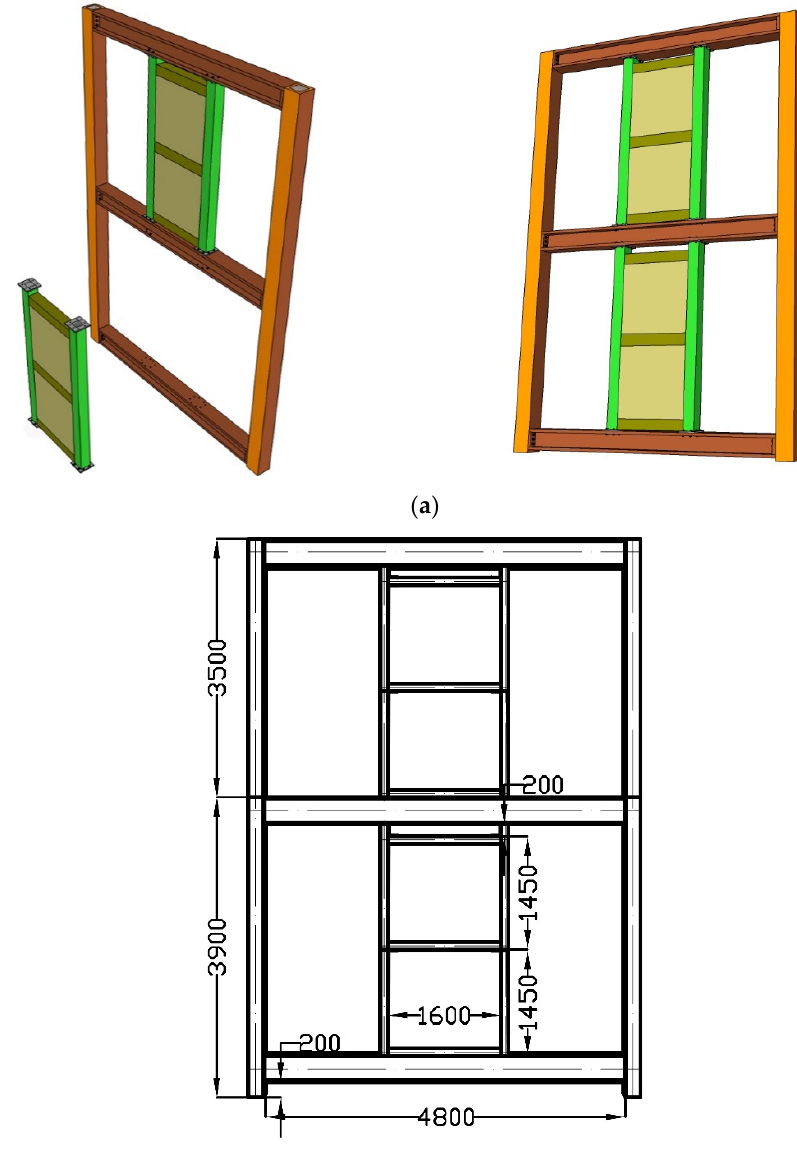
Figure 1. Steel frame structure with EDCWs. ( a ) Assembly; ( b ) structure diagram (Unit: mm).